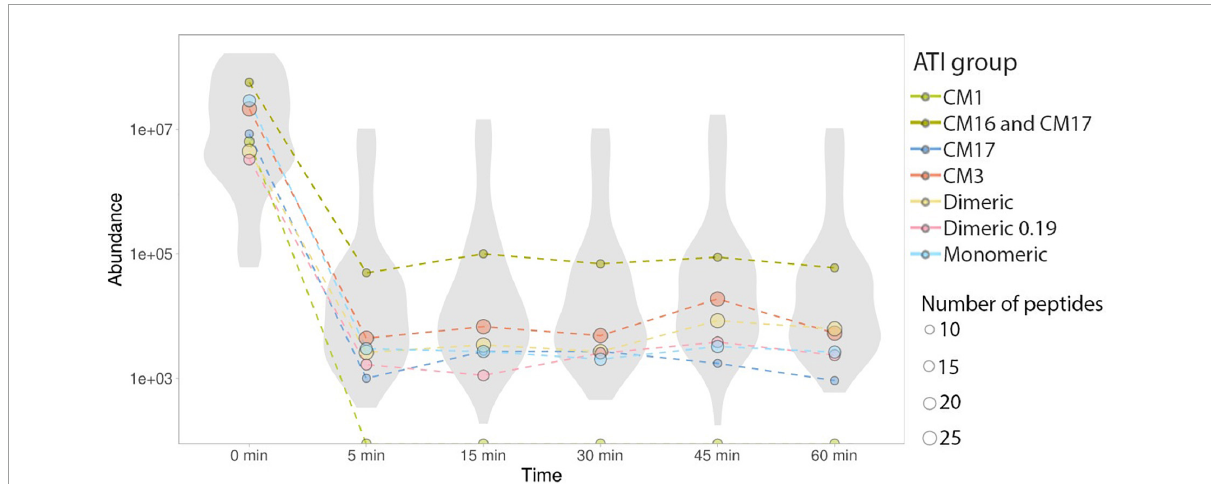
FIGURE3 Abundance changes of ATI type-specific peptides. In all detectable ATI subtypes, peptide abundance (reported as MRM peak area, log scale) decreased by orders of magnitude within 5 min and any change in abundance that occurred after this time was minimal. Median values of ATI subtype-specific peptide groups are labeled with colored dots. Dot size represents the number of peptides, sub-type specific data distribution and heterogeneity is highlighted using violin plots.